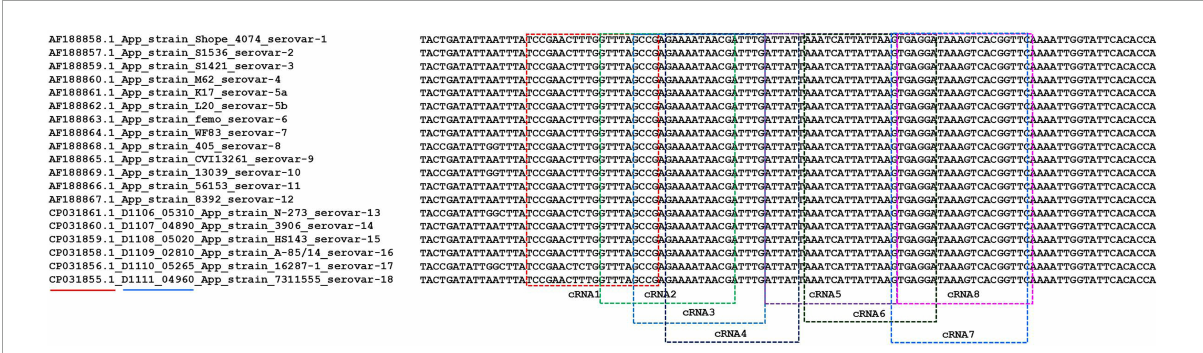
FIGURE2 The alignment of partial coding sequence of apxIVA of A. pleuropneumoniae serovars 1–18 downloaded from the NCBI database. Red underline indicates the accession number of the sequence in the NCBI database. Blue underline indicates the locus tag of the gene in the genomic sequence. The different colored frames indicate the recognized region of different crRNAs.